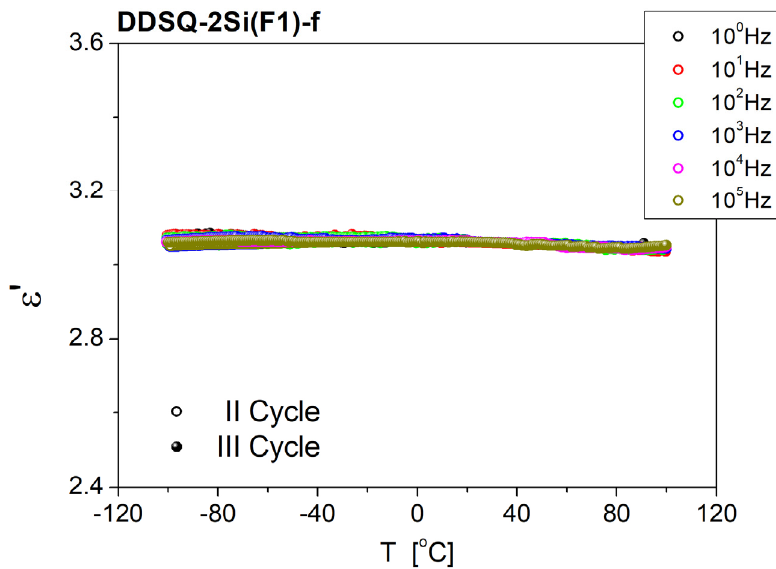
Figure 9. Temperature dependence of dielectric permittivity, measured for a thin film of DDSQ- 2Si(F1)-f . II cycle—sample was cooled from RT to T = − 100 °C; III cycle—sample heated from − 100 °C to 100 °C.